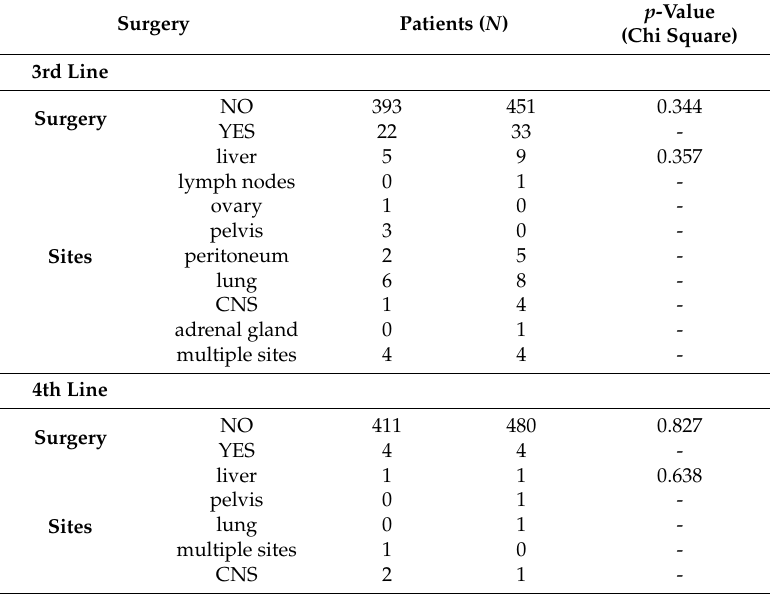
Abbreviation: CNS = central nervous system.